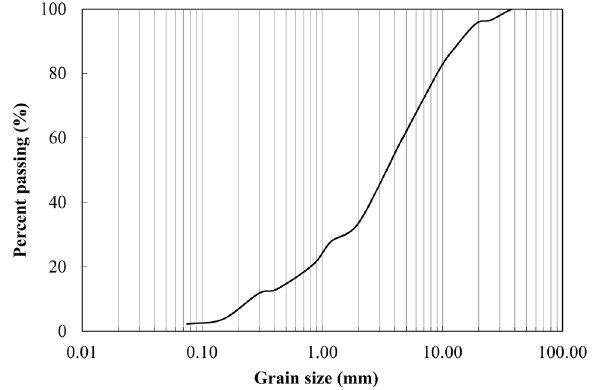
Fig. 3 The particle size distribution of soil fraction in the